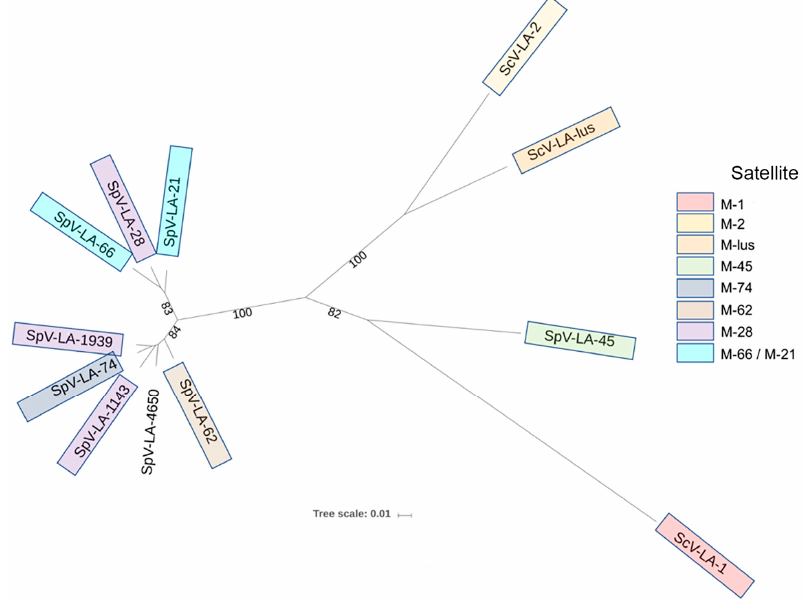
Figure 2. The phylogenetic tree of dsRNA-encoded Gag-pol proteins from S. cerevisiae and S. Figure paradoxus yeasts.